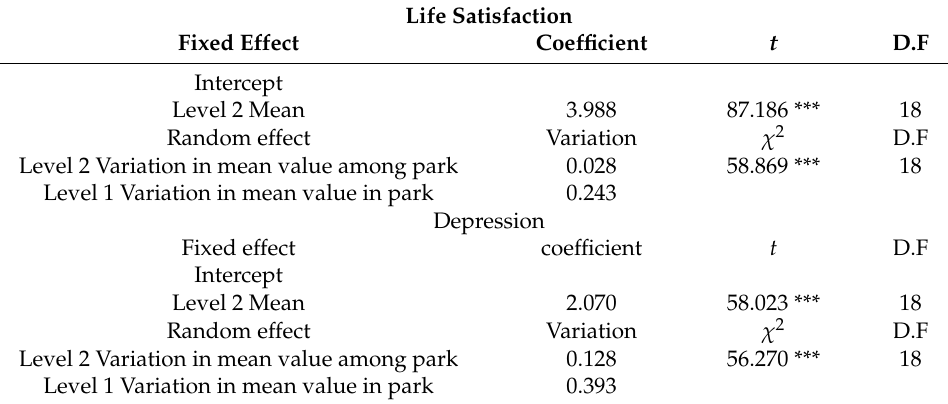
Table 5. Summary of the null model for life satisfaction and